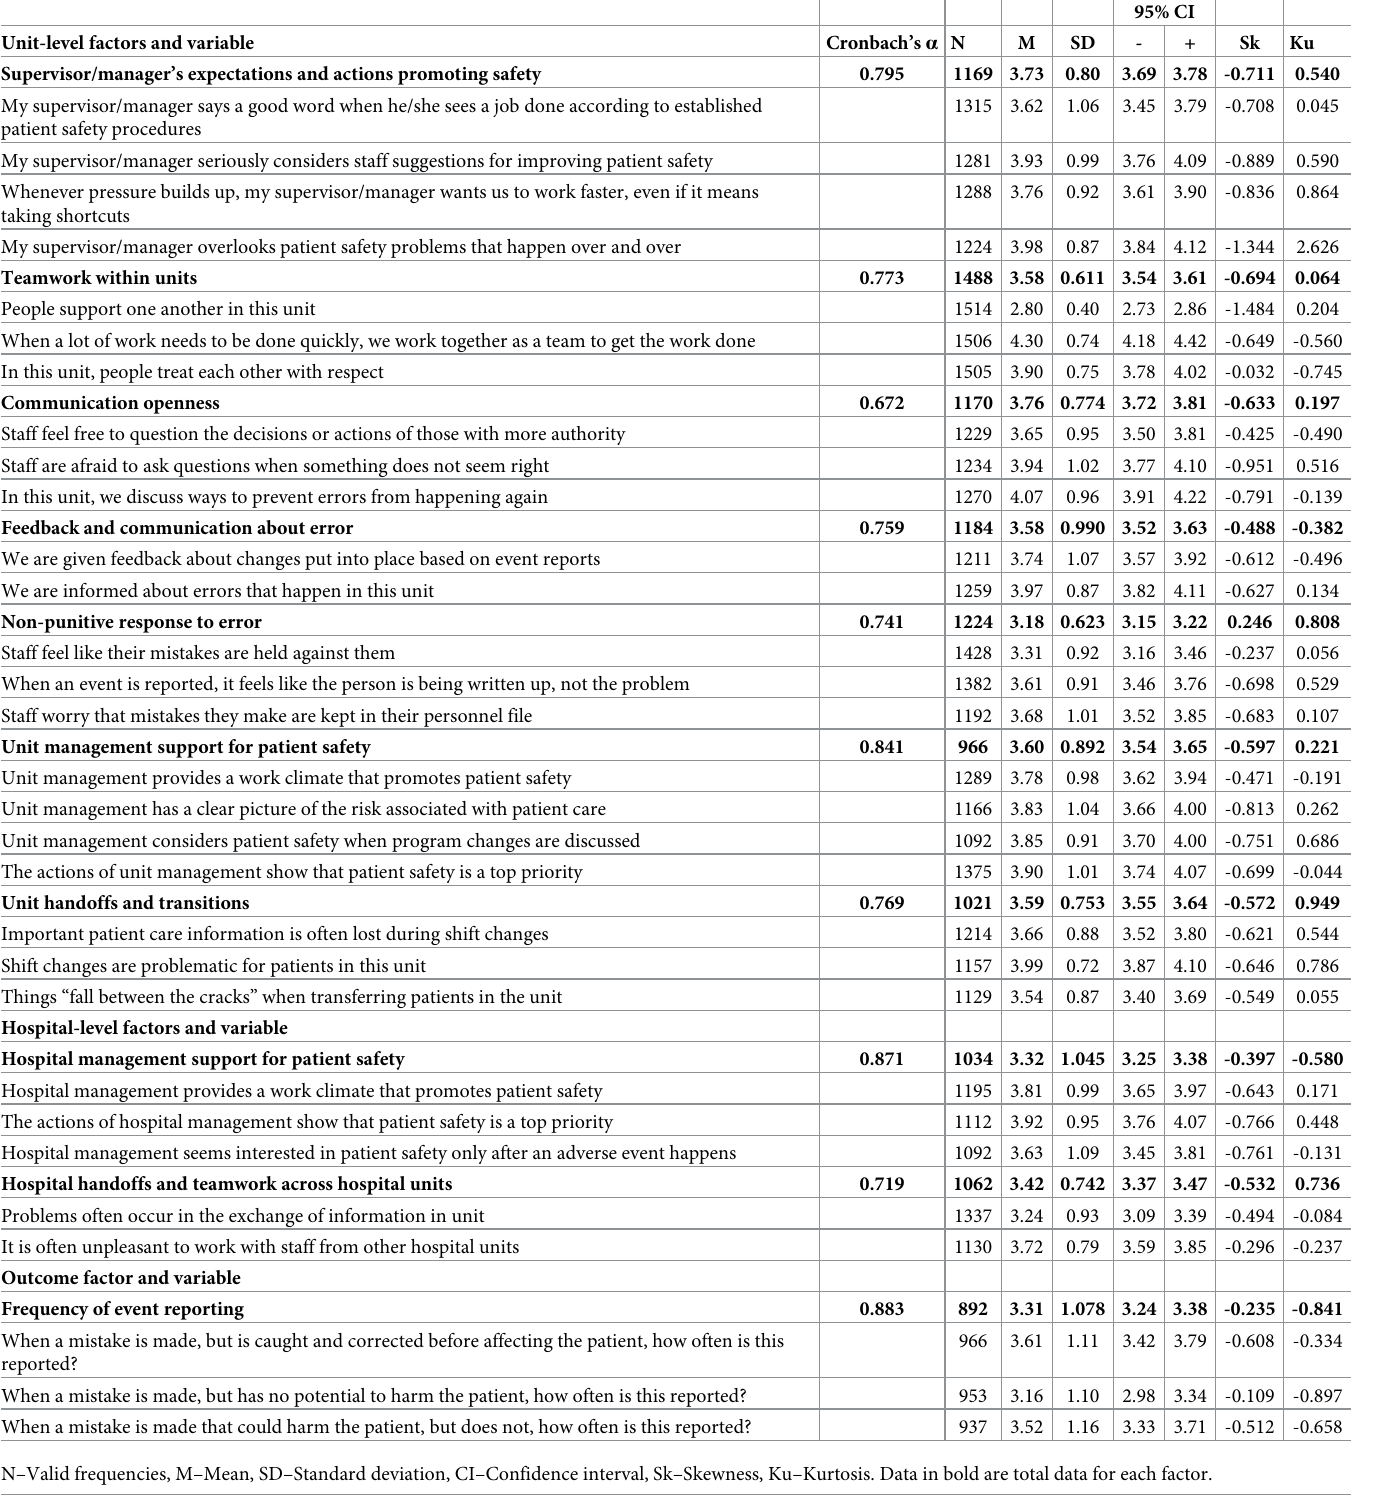
Table 3. Descriptive statistics for A-PaSKI (Factors and individual